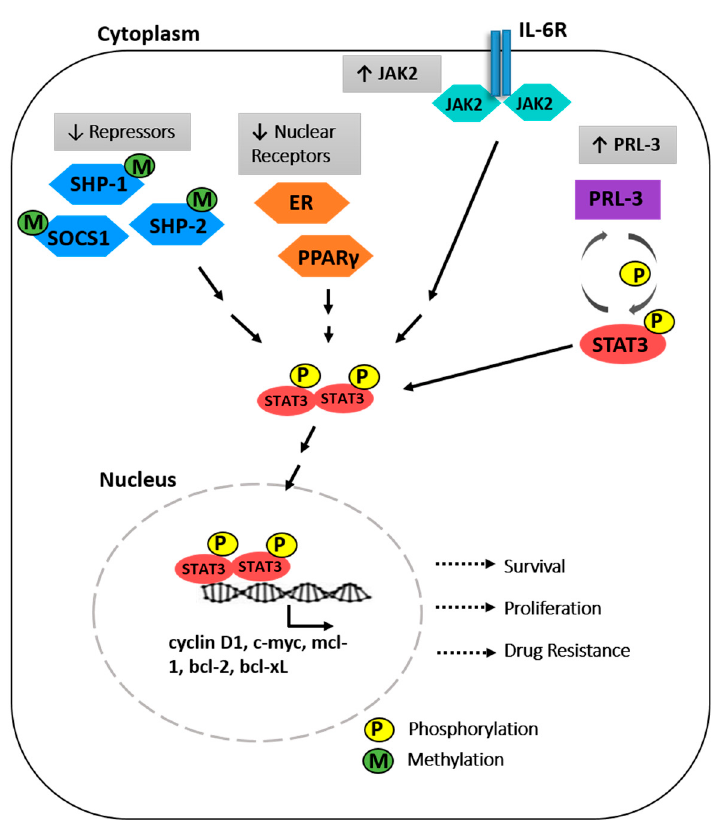
Figure 1. The molecular mechanisms driving constitutive signal transducers and activators of transcription (STAT3) activation in myeloma cells. Phosphorylated STAT3 translocate to the nucleus to mediate transcription of target genes, resulting in increased survival, proliferation and drug resistance of myeloma cells. Src homology containing protein 1 ( SHP-1 ), suppressor of cytokine signalling 1 ( SOCS1 ), phosphatase of regenerating liver 3 (PRL3), Janus Associated kinase (JAK), peroxisome proliferator activated receptors (PPAR), estrogen receptor